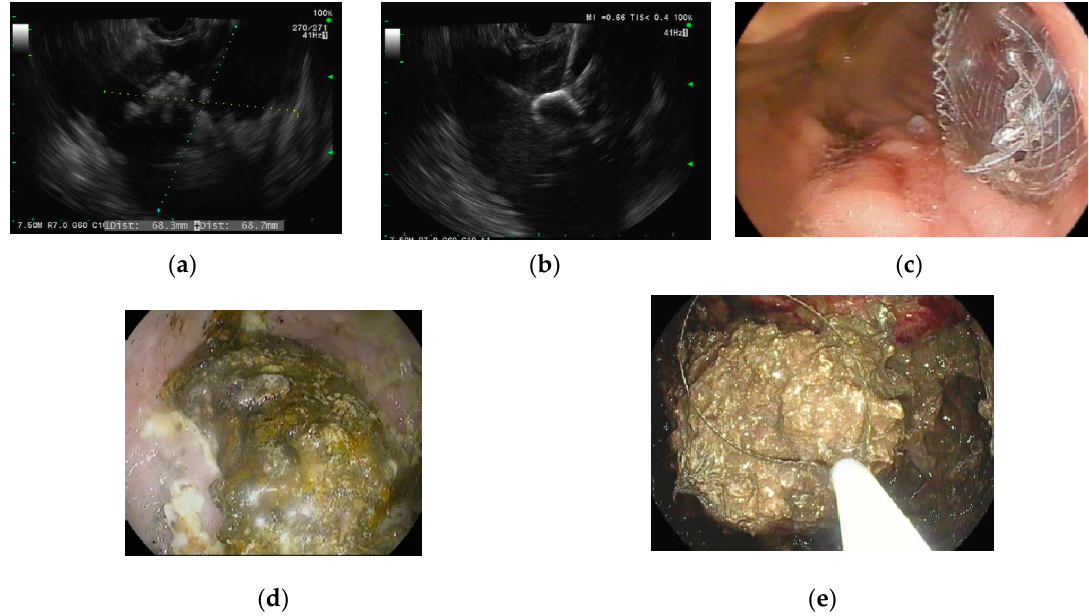
Figure 4. Endoscopic ultrasound-guided drainage using a LAMS with subsequent direct endoscopic necrosectomy for walled-off pancreatic necrosis (WOPN) ( a ) Endoscopic ultrasound imaging of cyst cavity with necrotic debris; ( b ) endoscopic ultrasound-guided placement of LAMS into WOPN; ( c ) endoscopic imaging post LAMS deployment in the stomach; ( d ) endoscopic imaging inside cyst cavity with necrotic material; and (e) direct endoscopic necrosectomy performed using a snare.